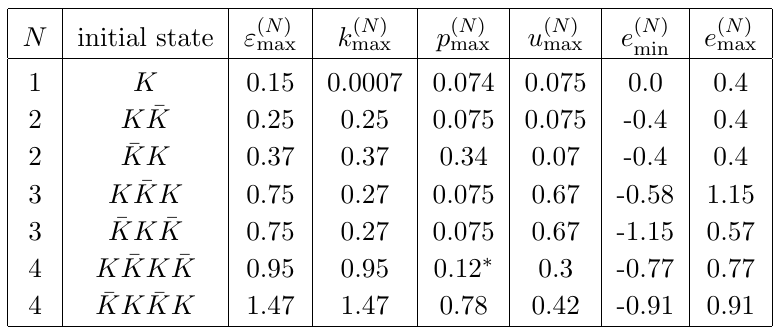
Table 2. Extreme values of the energy densities and the (cid:12)eld gradient observed in the studied kink